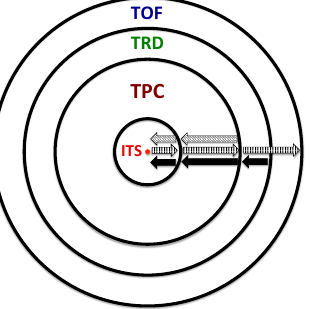
Figure A.2.: Schematic view of the three passes of the combined track finding [92]. Figure 1. Schematic view of the three passes of the combined track finding [5,6]. Central barrel detectors are shown as cross-sections perpendicular to the beam direction from innermost (ITS) to outermost (TOF) detectors.